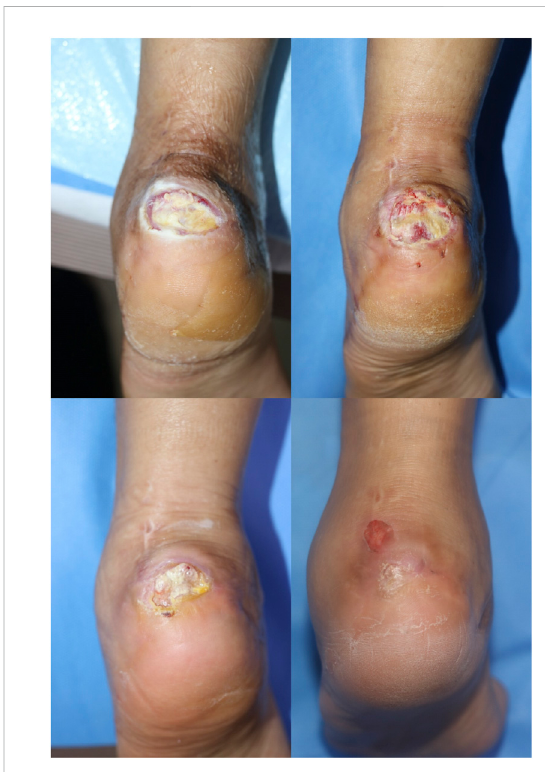
FIGURE 5 Case 1. A 34-year-old female with a history of orthostatic hypotension presented with soft tissue necrosis on the left heel duetoapressuresore(above,left).Afterapplyingpure-grindADM, wounddepthandsizeimproved(above,rightandbelow,left). After7 weeks,thepreviouspure-grindADMapplicatedwoundwas completely healed, and a newly abrasion wound was seen, which was not associated with the previous treatment course (below, right).